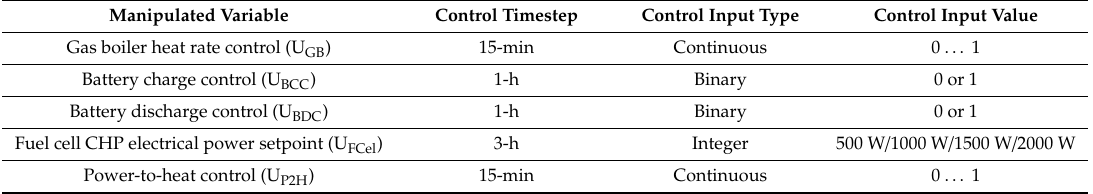
Figure 5. The manipulated variables and the output variables of the iHEM energy system. Table 2. Boundary conditions for the respective manipulated variable.